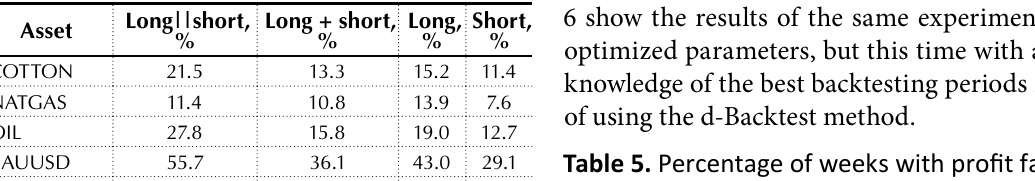
Table 5. Percentage of weeks with profit factor